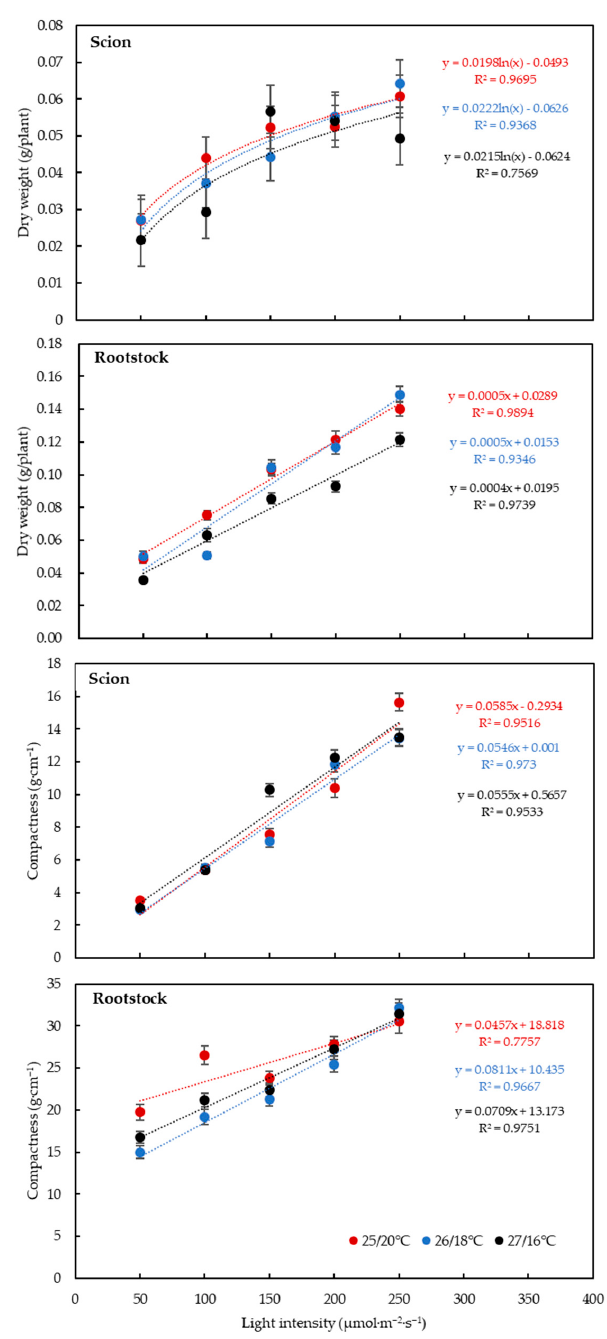
Figure 5. Regression analyses of the dry weight and compactness of cucumber scions and rootstocks as affected by the different air temperature and light intensity treatments in a PFAL. The values of each point represent means for 3 replicates with 7 samples and standard errors.